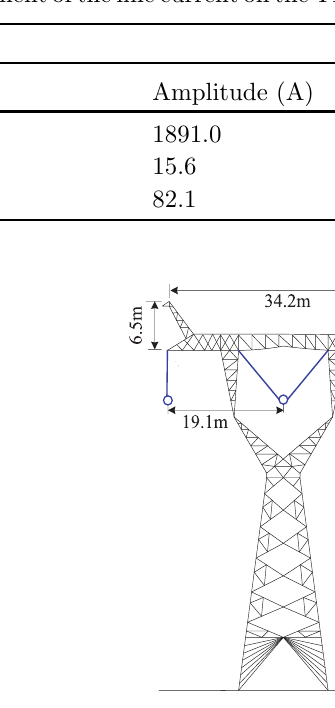
Fig. 3. Schematic diagram of the structure of the transmission line tower.